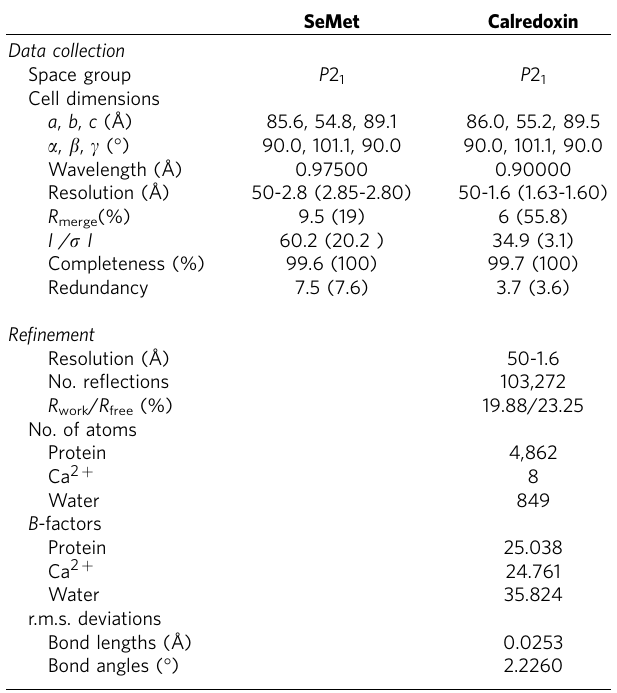
Table 1 | Data collection, phasing and refinement statistics for single-wavelength anomalous dispersion (SeMet)